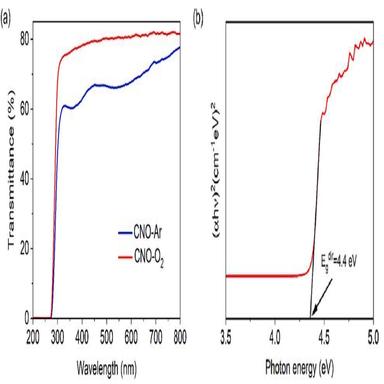
(a) The UV–visible optical measured transmission spectra of CNO-Ar and CNO-O2, (b) the variation of (αhν) 2 vs. photon energy (hν).